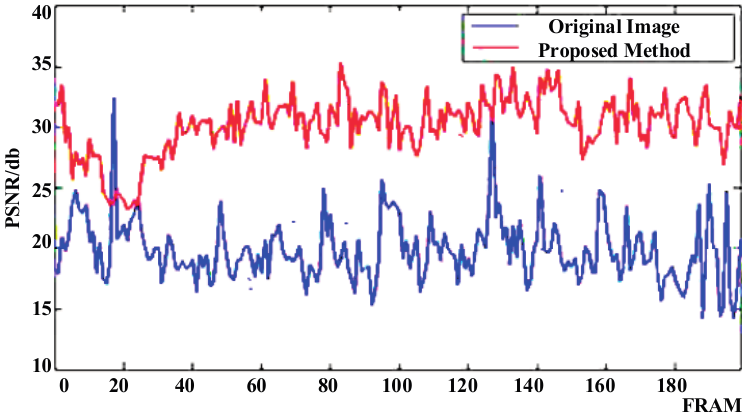
Figure 9. Peak Signal to Noise Ratios (PSNR) for two experiments: Those for the original image and the proposed method, using two